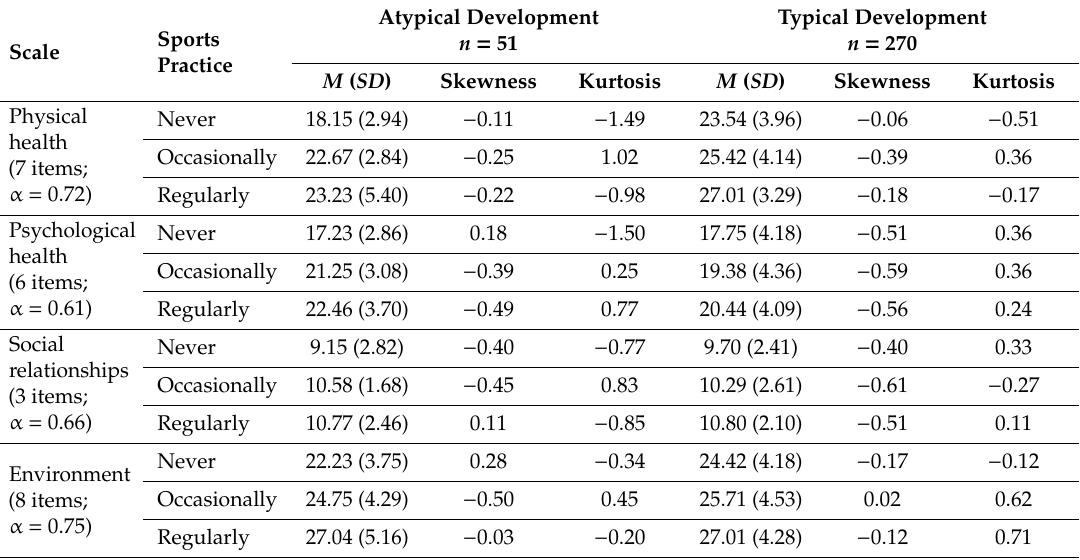
Table 3. Descriptive statistics of the World Health Organization Quality of Life – BREF